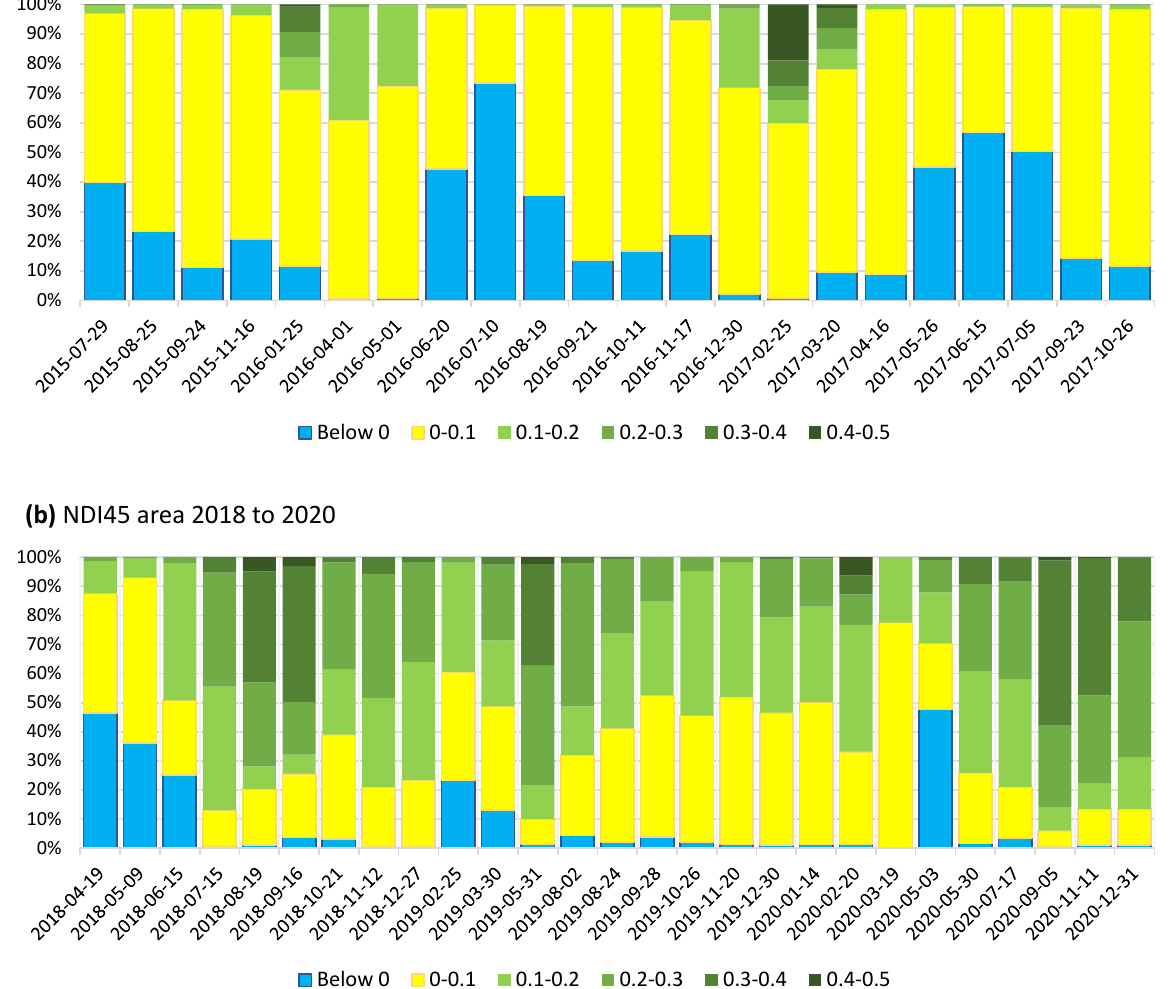
Figure 6. Time series in vegetated area in NDI45 classes = 0.1–0.2–0.3–0.3–0.4–0.5. ( a ) Series between summer 2015 and fall 2017, when the lagoon completely dries out. ( b ) Series from spring 2018 (when it floods again) to the end of 2020.